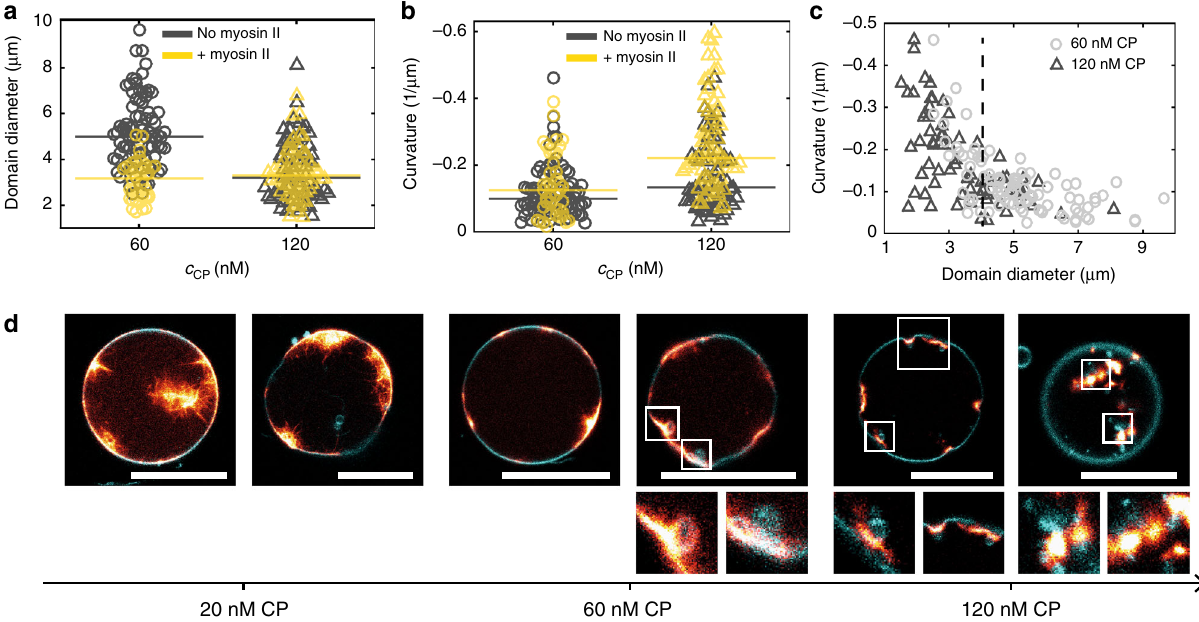
Fig. 4 Contractile network behaviour depends on CP. a , b Domain diameter and curvature of negatively bent domains were measured in the absence or presence of non-muscle myosin II. a The median diameter decreased from 5 µ m at 60 nM CP (grey circles) to 3.2 µ m at 120 nM CP (grey triangles). Upon addition of 5 µ M non-muscle myosin II to the solution prior to encapsulation the domain diameter contracted to 3.2 µ m at 60 nM CP (yellow circles) and remained constant at 120 nM CP (yellow triangles). b The median curvature increased from 0.1 µ m − 1 at 60 nM CP (grey) to 0.13 µ m − 1 at 120 nM CP (grey). The addition of 5 µ M non-muscle myosin II increased the curvature to 0.12 µ m − 1 at 60 nM CP (yellow) and to 0.22 µ m − 1 at 120 nM CP (yellow). c Scatter plots of the domain curvature vs. the domain length show that the domain diameter directly correlated to the domain curvature. Only small domains (<4 µ m) had curvatures up to 0.5 µ m − 1 . d Confocal images of the equatorial vesicle ’ s plane showed the interactions of the contractile actin network (red hot) with the membrane (cyan). At 20 nM CP the network detached from the membrane and was pulled towards the bulk of the vesicle. At 60 nM CP membrane invaginations (insets) emerged from the membrane. At 120 nM CP membrane invaginations (left inset) and fi ssion events (right insets) could be observed. Scale bars are 20 µ